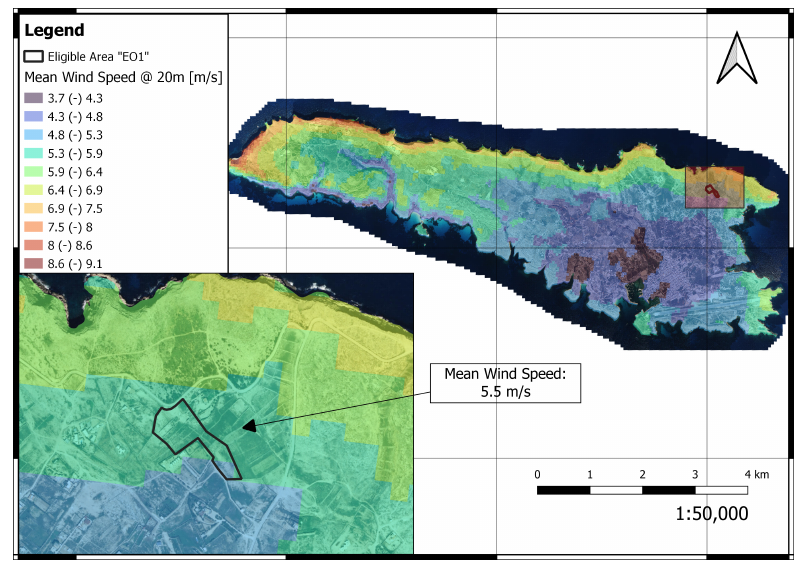
Figure 22. Mean wind speed and suitable areas in Lampedusa